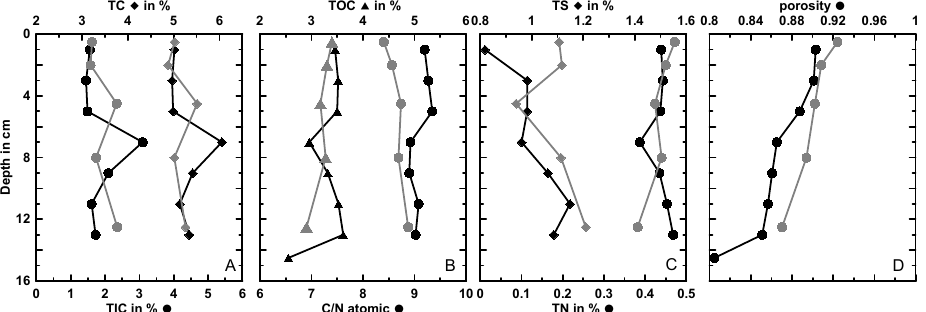
Figure 9. Sediment solid-phase parameters measured in the sediment of the ex situ replicate of the SO206-31 (MUC) core (grey lines and symbols) compared to the NLFC (original HFC, black lines and symbols). Total carbon content (TC, diamonds) and total inorganic carbon content (TIC, circle) in drywt.% (a) , atomic C / N ratio (circle) and total organic carbon content (TOC, triangles) in drywt.% (b) , total nitrogen (TN, diamonds) and total sulfur (TS, circles) in drywt.% (c) , and porosity of the sediment (d)